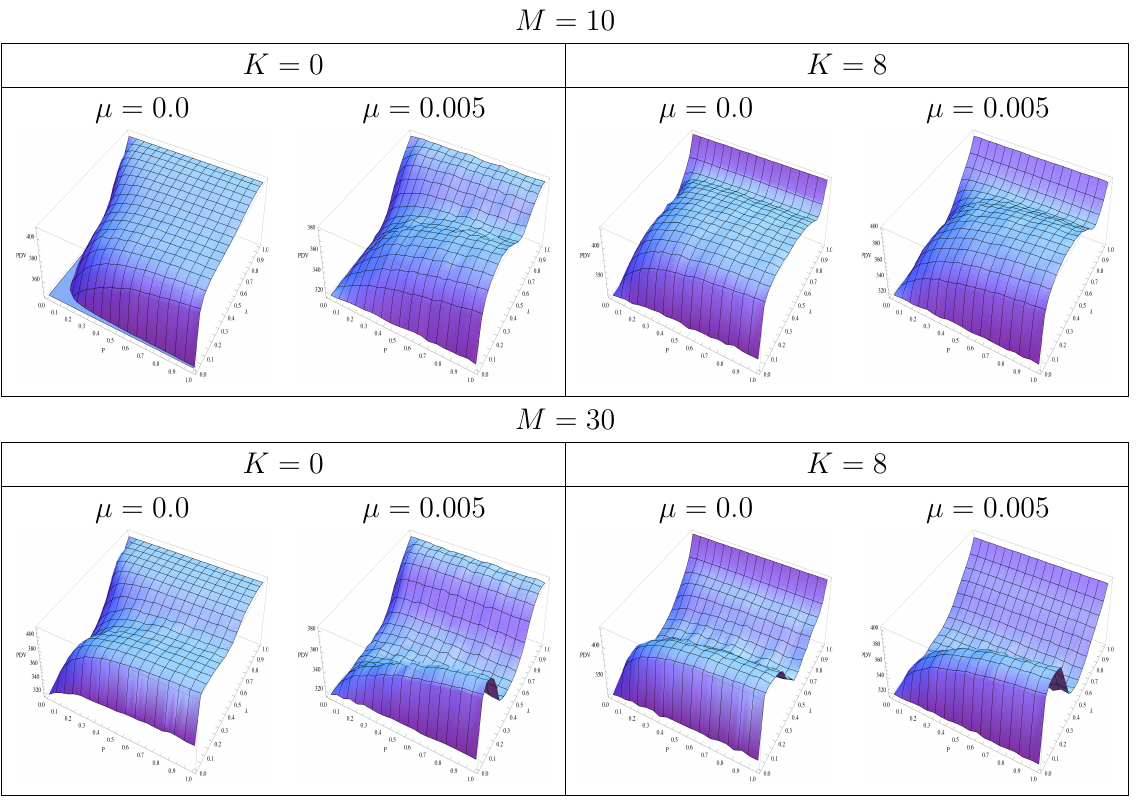
Figure 7. Average PDVs of organizational performances for M = 10 ( top ) and M = 30 ( bottom ) for four combinations of K ∈ { 0 , 8 } and µ ∈ { 0 . 0 , 0 . 005 } . Based on the average results from 100 simulation